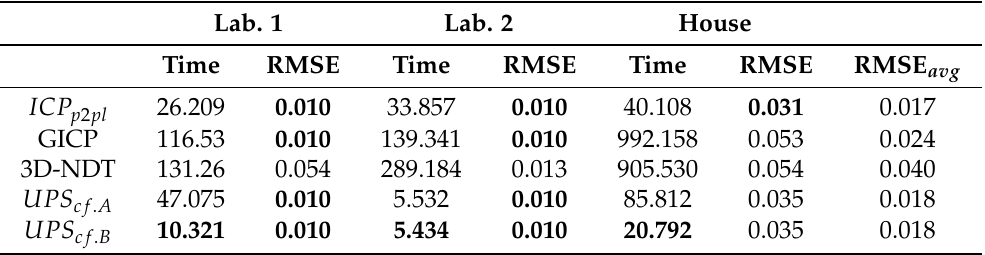
Table 11. Running time (in seconds) and RMSE (in meters) to align multiple partial shots of indoor scenes.